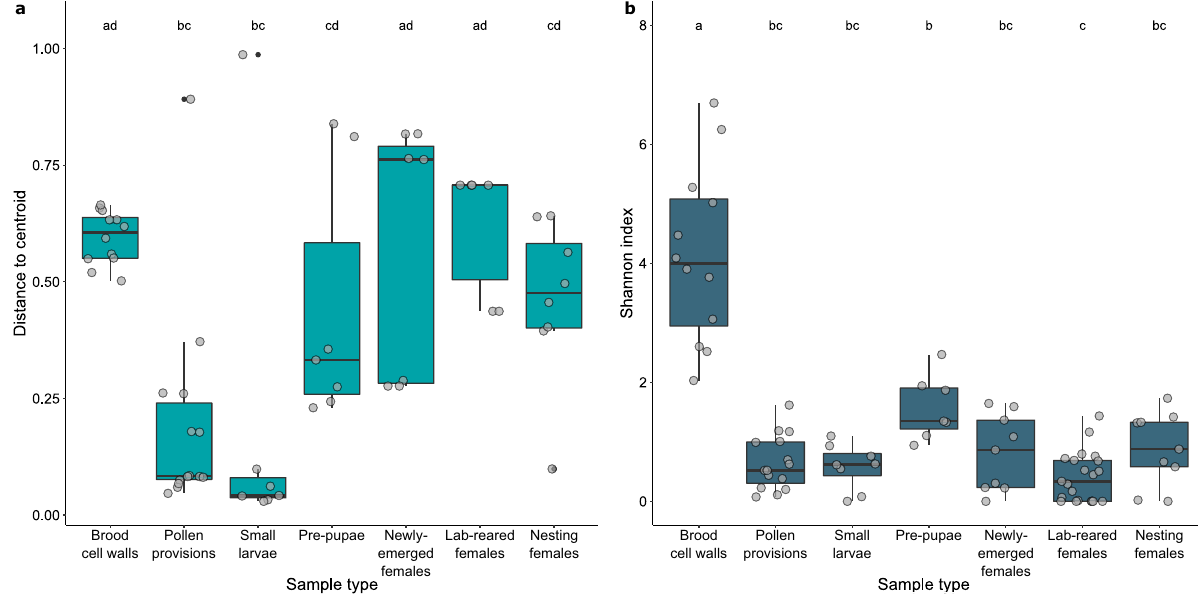
Figure 3. Bacterial diversity across sample types. ( a ) Multivariate dispersion displayed as distance from the centroid. ( b ) Alpha diversity calculated as Shannon index. Boxes represent the interquartile range, with a line indicating the median. Whiskers extend to 1.5 times the interquartile values. Gray filled circles represent data from individual samples. Different letters along the top indicate significant (Tukey adjusted p < 0.05) differences between sample types. There are more samples in ( b ), because unfiltered data was used to calculate Shannon